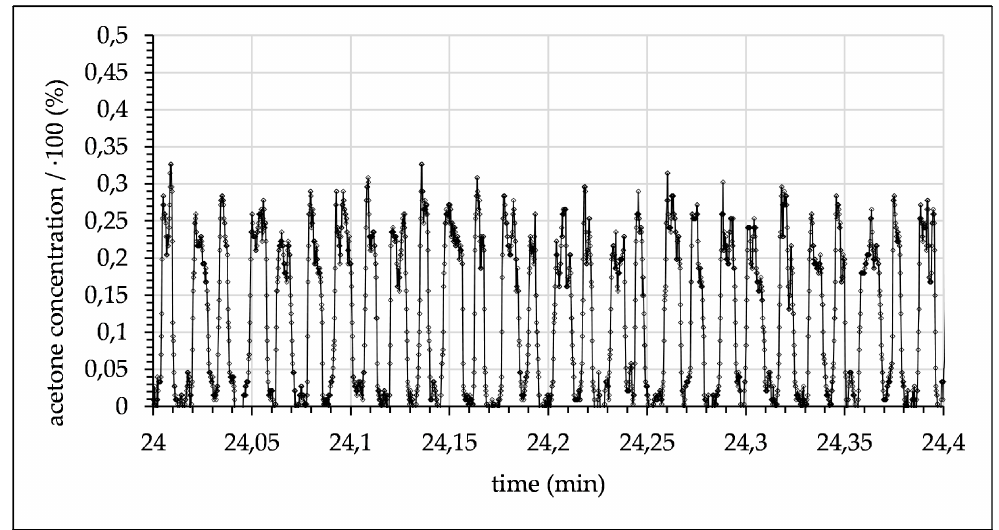
Figure 9. Measured acetone concentration in toluene droplets alternating with water droplets (0.06 mL/min with 2.5 s time delay after contact of toluene and water).